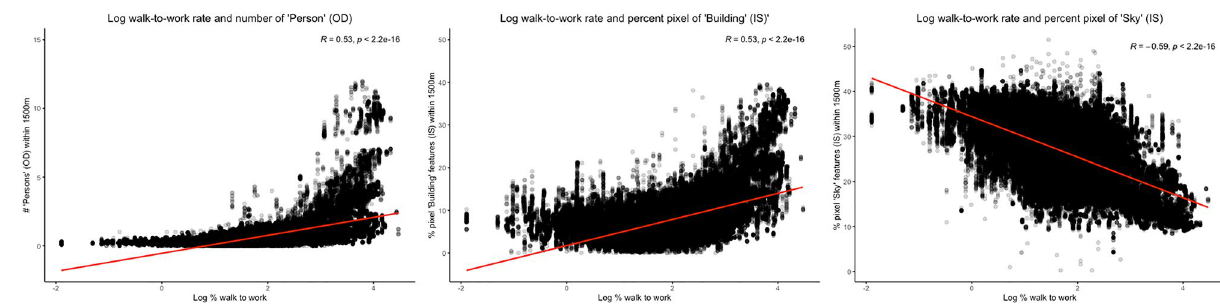
Figure 3. Linear relationships of GSV features within 1500 m from postal code with log-transformed walk-to- work